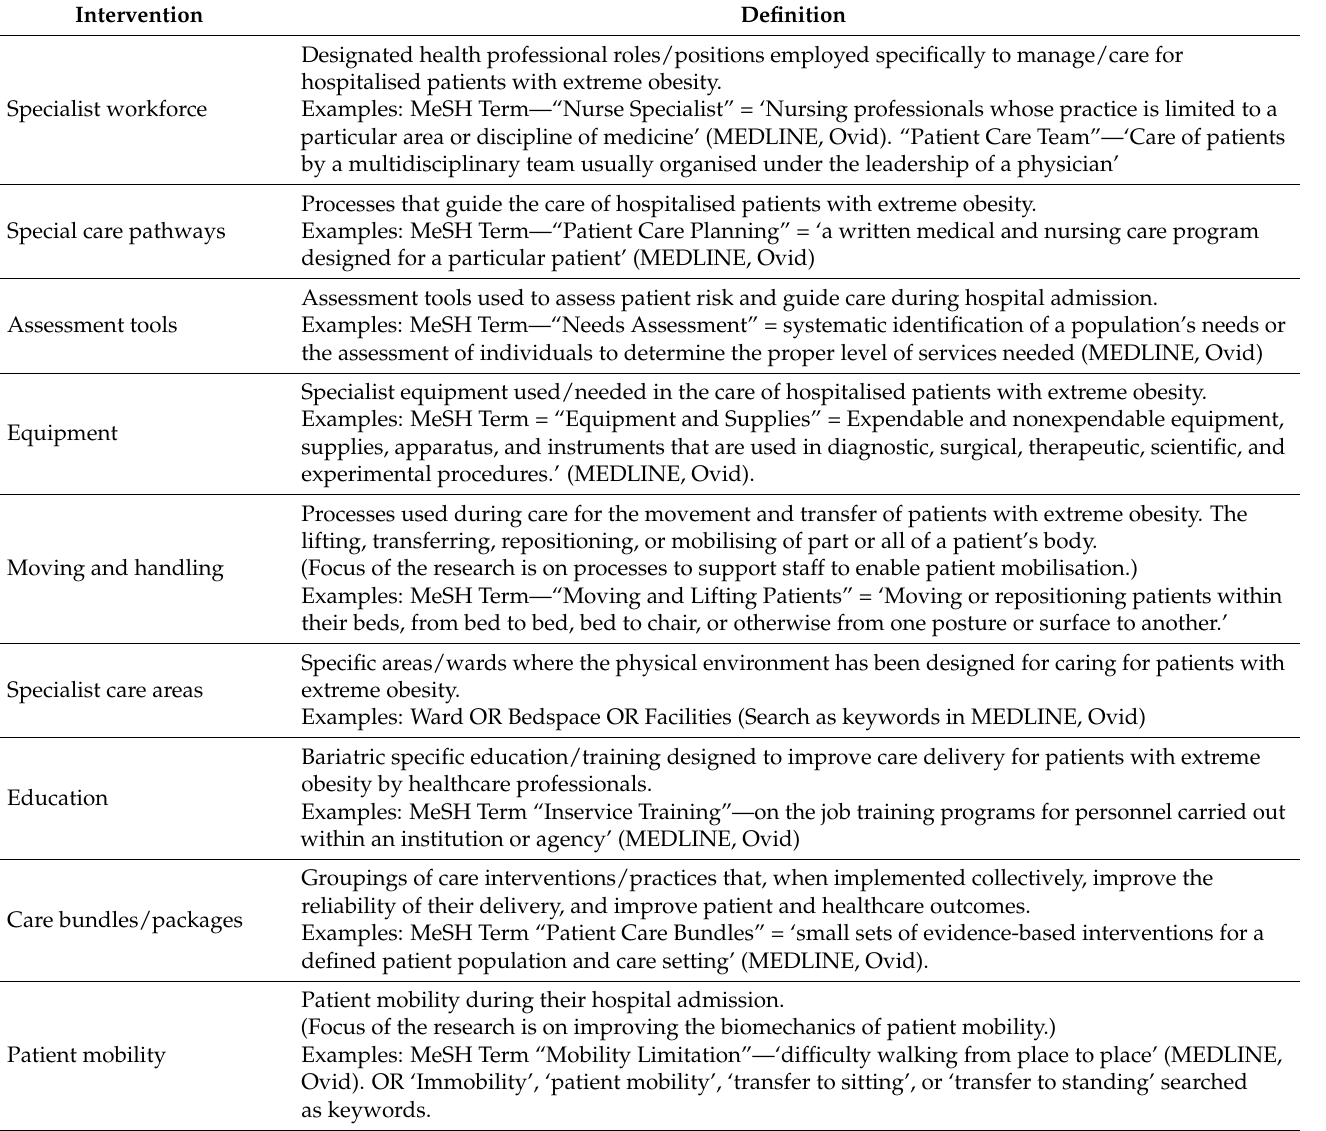
Table 1. Intervention